Question: Draft a figure caption describing what is shown.
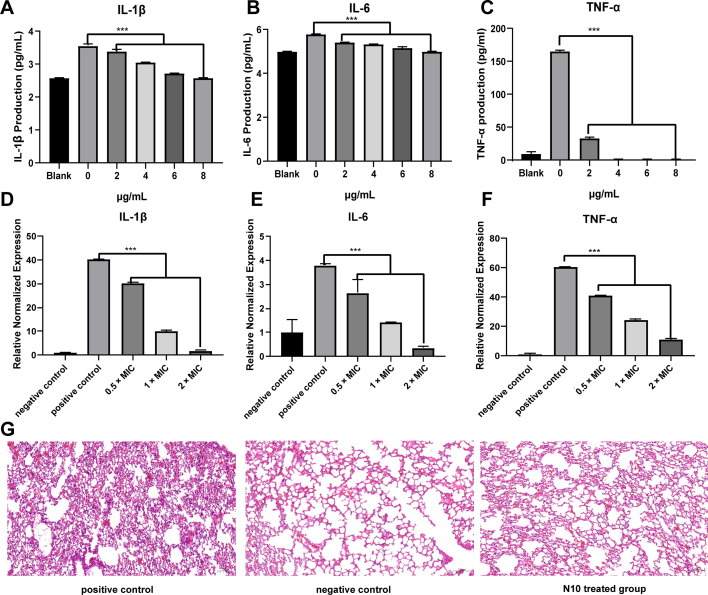
Answer: N10 has excellent anti-inflammatory effects. The level content of IL-1β ( A ), IL-6 ( B ), and TNF-α ( C ) in E. coli -infected HeLa cells. Relative gene expression levels of IL-1β ( D ), IL-6 ( E ), and TNF-α ( F ) in E. coli -infected HeLa cells. ( G ) E. coli pneumonia infection model and therapeutic sections. The phosphate-buffered saline (PBS) injection group was used as a negative control, and the infection untreated group was used as a positive control. Scale bars: 100 μm. Student’s t -test was applied for statistical analysis. Data are presented as mean ± standard error of the mean, significance levels were defined as P < 0.001 (***).